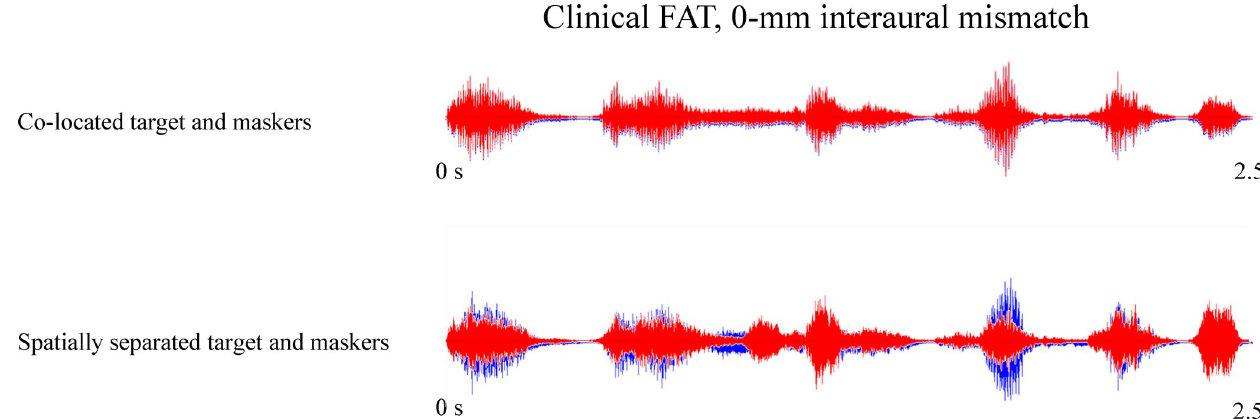
Fig 4. Combined target with co-located or spatially separated maskers. The TMR was 0 dB. Waveforms are shown after HRTF and the bilateral CI simulation was applied. The blue and red traces show the waveforms presented to left and right ears, respectively. The left and right waveforms are slightly offset for visual